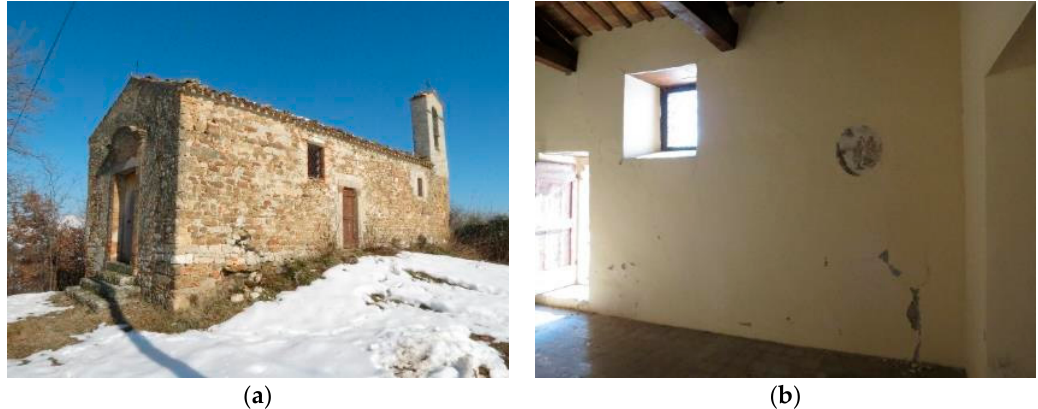
Figure 7. Example of damage due to soil settlement occurring after a seismic event: ( a ) visible outside a church; and ( b ) inside a church.